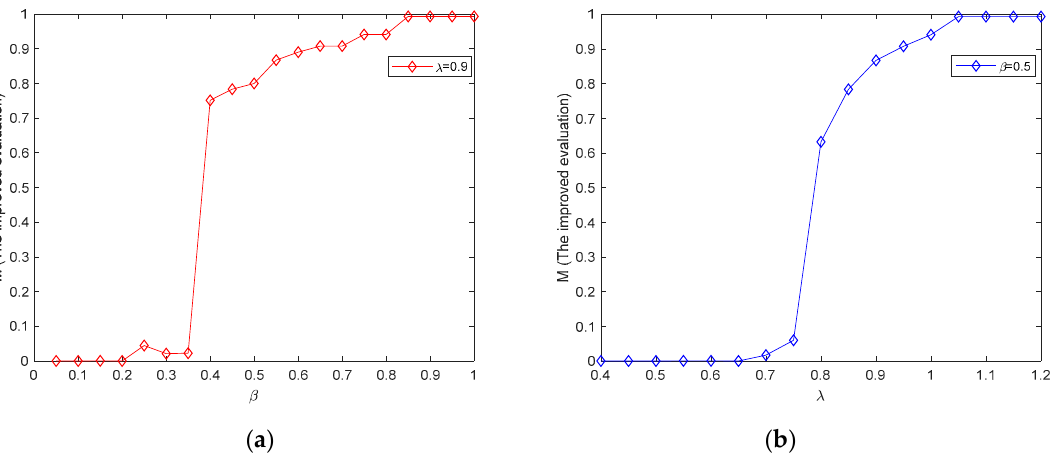
Figure 4. Effect of capacity regulation parameters: ( a ) the effect of exponential adjustment pa- rameter on invulnerability performance and ( b ) the effect of overload tolerance on invulnerability